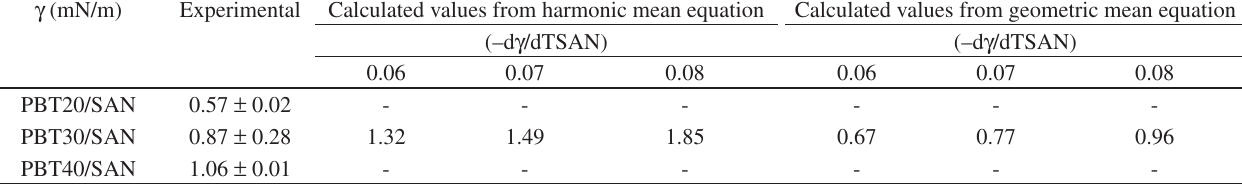
Table 5. Experimental and calculated values of the interfacial tension ( g ) of the PBT/SAN system. g (mN/m) Experimental